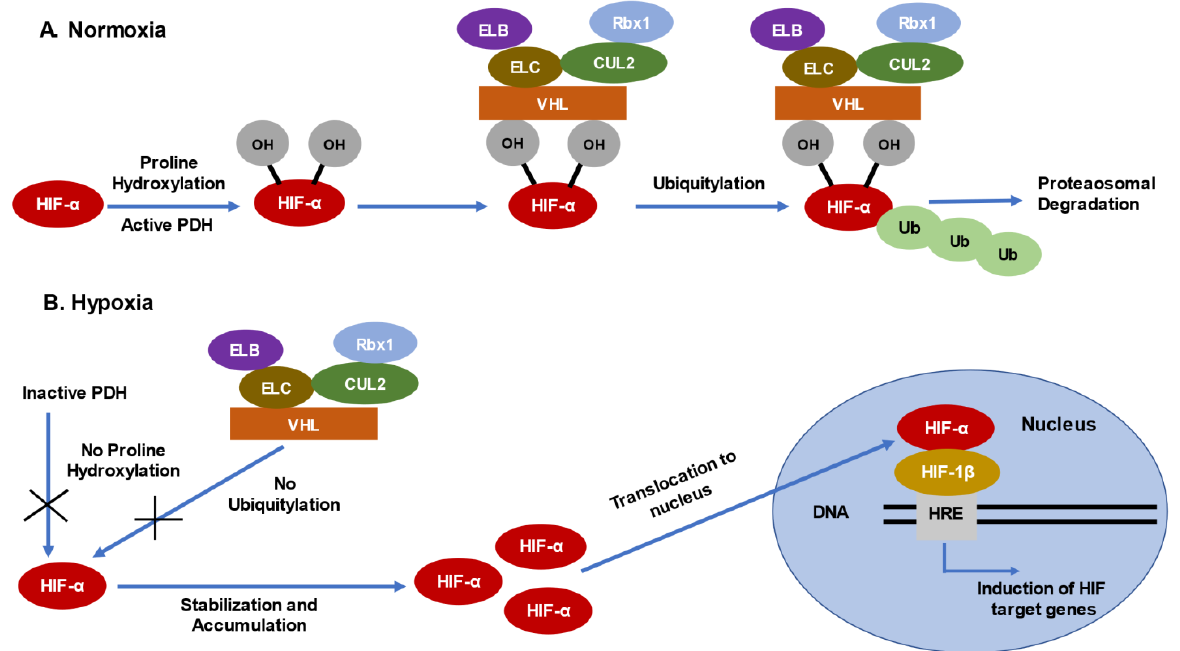
Figure 1. Regulation of HIF-α via VHL-dependent ubiquitylation and proteasomal degradation. ( A ) Alpha subunits of the Hypoxia Inducible Factors (HIFs) are constitutively expressed but are tightly regulated. Under normal oxygen availability, HIF-α subunits are hydroxylated at specific proline residues via the activity of Proline Hydroxylases (PDHs), which target HIF-α for degradation via VHL- dependent recognition and ubiquitination. ( B ) Under low oxygen availability, however, PDH- dependent hydroxylation of proline residues in HIF-α is absent; as a result, recognition via VHL and subsequent HIF- α degradation is inhibited. Consequently, HIF- α subunits are stabilized, accumulate, and translocate to the nucleus, forming heterodimeric complexes with HIF-1 β subunits. This complex interacts with the (HIF Response Element) HRE in DNA to induce the expression of HIF target genes that regulate angiogenesis, cell growth, cell cycle progression, cell proliferation, glycolysis, and apoptosis to maintain cell growth and survival under hypoxic